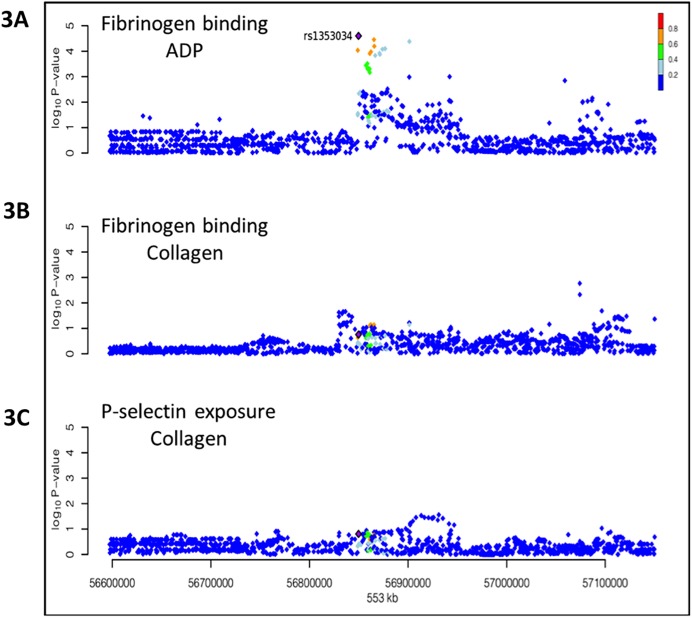
rs1354034 is associated with human platelet function.(A-C) Association studies on SNPs and human platelet function. X axis: Genomic position. Y axis: -log10 (P-value from linear additive association). The three quantitative traits measured by flow cytometry are fibrinogen binding in response to ADP (A) or Collagen (B) and P-selectin expression in response to Collagen (C). The purple diamond represents the lead SNP and the colour of the other SNPs is based on the linkage disequilibrium (in terms of r2) with the lead SNP.